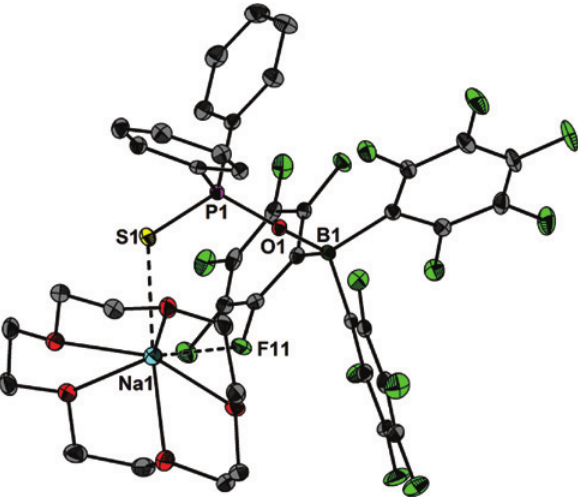
Figure 1: Molecular structure of 1 showing 50% probability ellip- soids and the crystallographic numbering